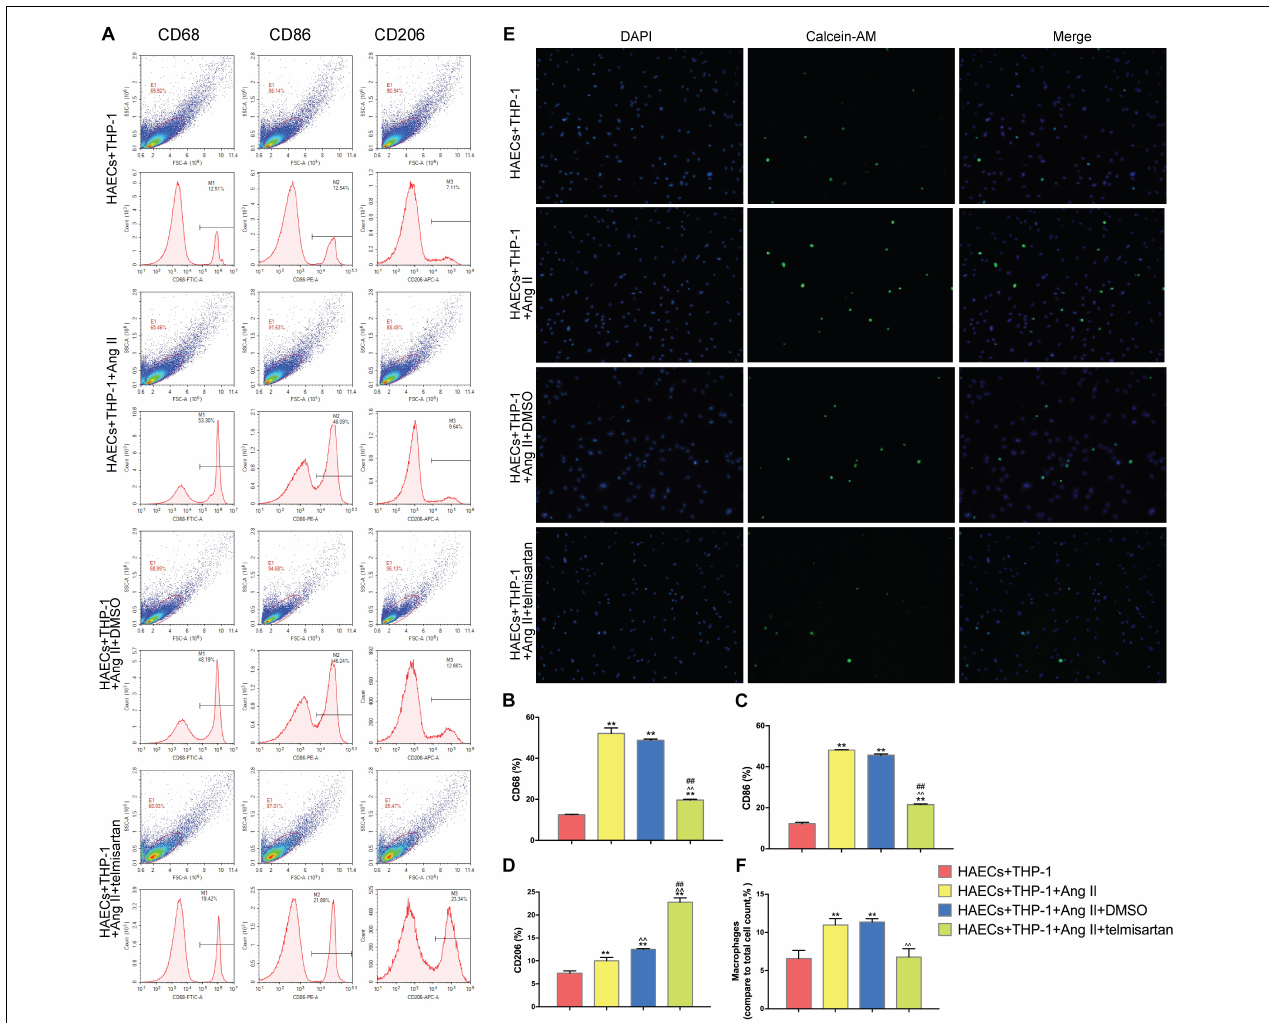
FIGURE 2 | Ang II promotes THP-1 polarization to a CD68 + CD86 + phenotype and increases THP-1 adhesion. Telmisartan attenuates these effects and promotes THP-1 polarization to a CD206 + phenotype. (A) Flow cytometry analysis of CD68, CD86, and CD206 expression in the different groups after 96 h co-culture. The data shown in the one-factor histogram for each group represent the cells in the red circle in the upper scatter plot. HAECs + THP-1 group: CD68, 12.51%; CD86, 12.54%; CD206, 7.11%. HAECs + THP-1 + Ang II (1 µ M, 24 h) group: CD68, 53.30%; CD86, 48.09%; CD206, 9.64%. HAECs + THP-1 + Ang II (1 µ M, 24 h) + DMSO (20 µ M, 24 h) group: CD68, 48.19%; CD86, 46.24%; CD206, 12.66%. HAECs + THP-1 + Ang II + telmisartan (20 µ M, 24 h) group: CD68, 19.42%; CD86, 21.89%; CD206, 23.34%; (B,C) The proportion of CD68 + and CD86 + cells, respectively [ n = 3, mean and Standard Deviation (S.D.), t -test, ** P < 0.05 compared with the HAECs + THP-1 group; ∧∧ P < 0.05 compared with the HAECs + THP-1 + Ang II group; ## P < 0.05 compared with the HAECs + THP-1 + DMSO group]. The proportion of CD68 + and CD86 + cells was significantly increased by treatment with Ang II ( P < 0.01), and